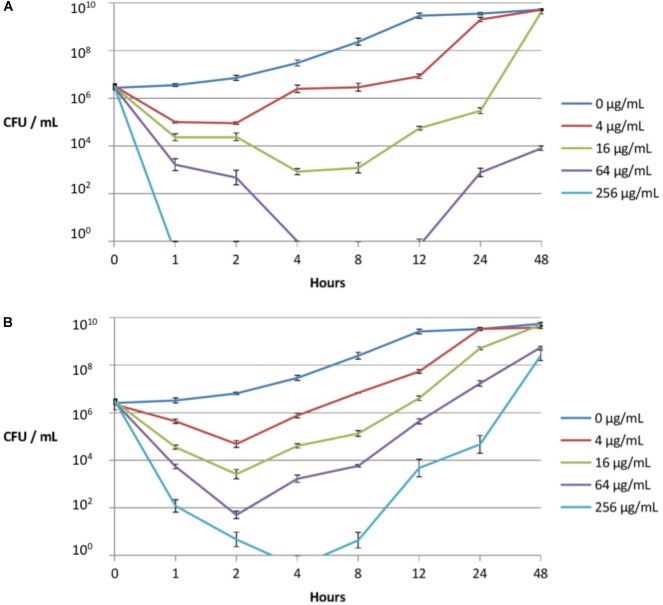
Time-kill kinetics of peptidomimetic LBP-2 (A) and colistin (B) against a clinical resistant strain (PA1603; with phoQ and pmrAB mutations) isolated from a CF lung. Error bars indicate ± SD.